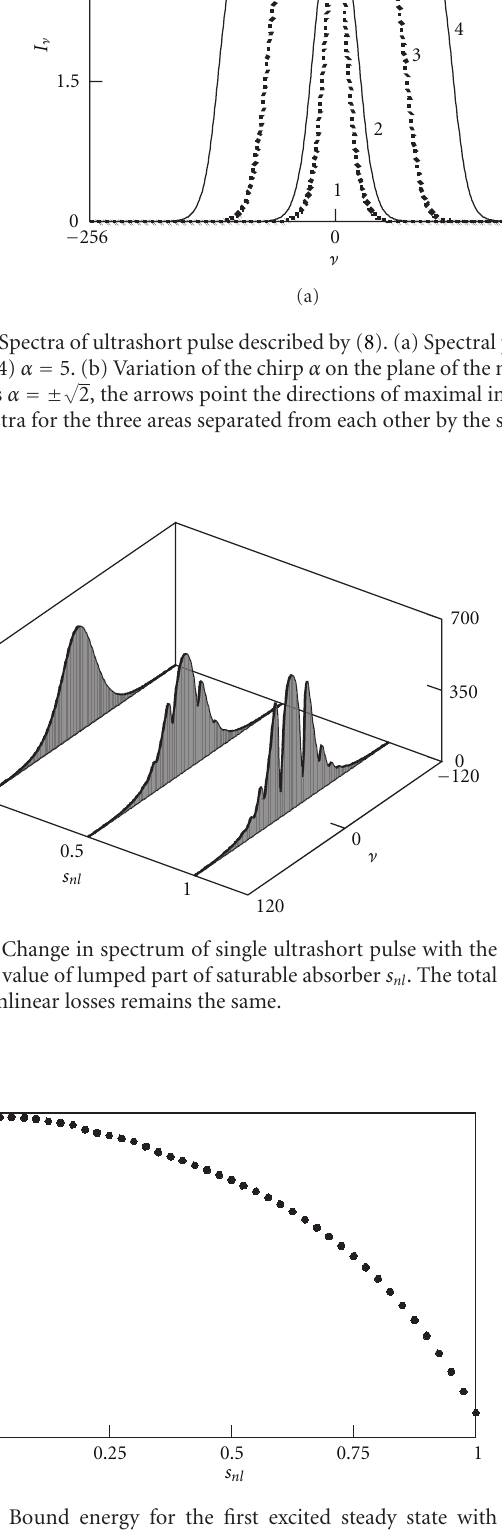
Figure 17: Bound energy for the first excited steady state with changing value of a lumped part of a saturable absorber s nl .